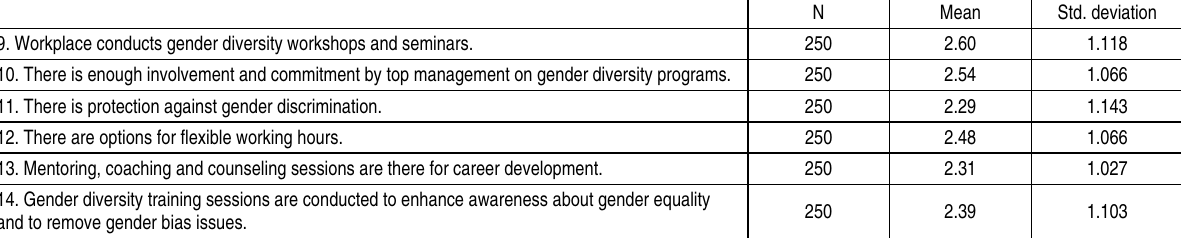
Table 8. Gender diversity management programs and practices